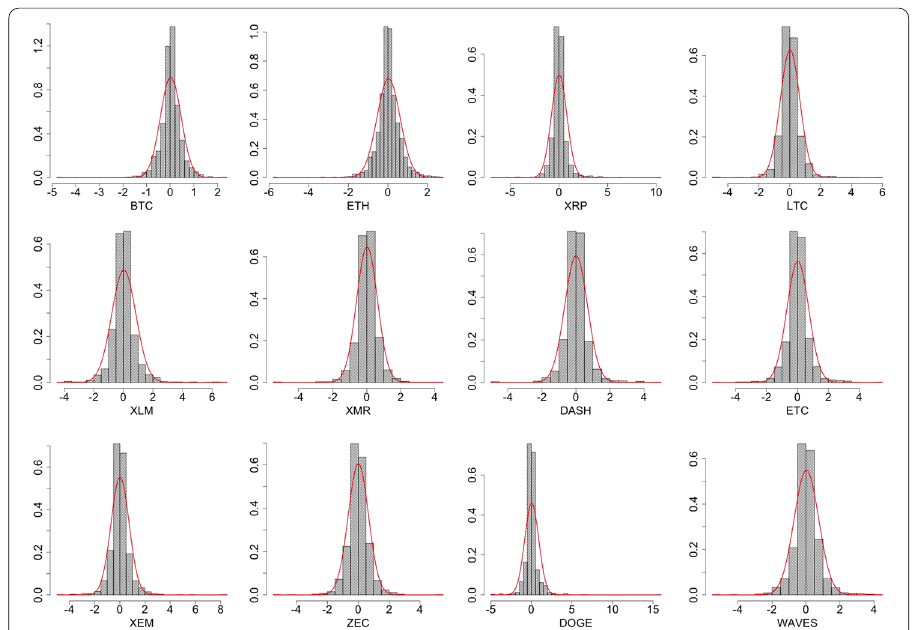
Fig. 4 Histograms of the 12 CCs’ log return considered